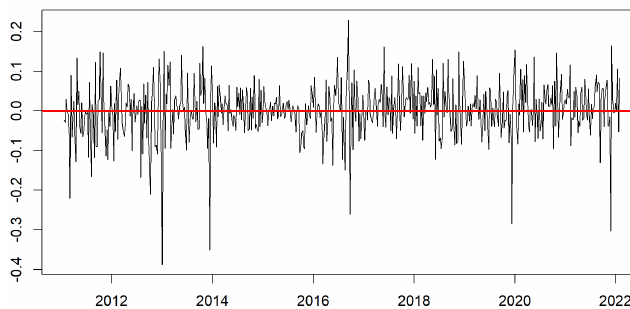
Figure 7. Log − Differenced Residuals.